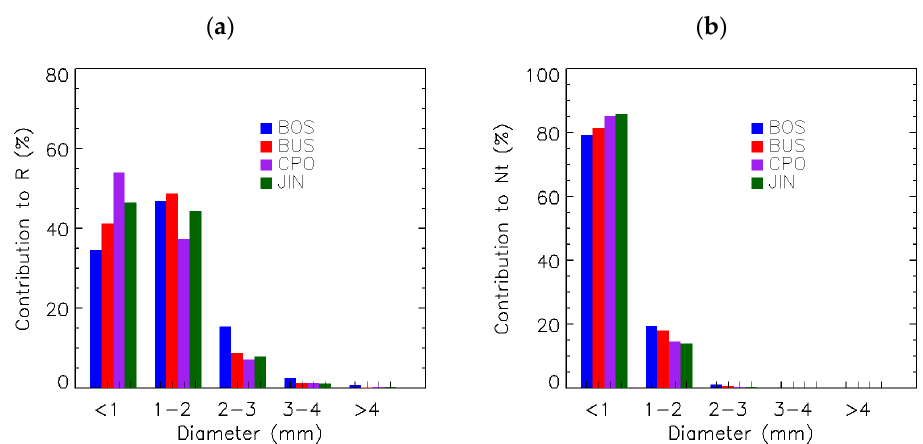
Figure 6. The contribution ratios of the raindrop diameter to ( a ) the rain rate and ( b ) the total number concentration. The blue represents BOS site, the red represents BUS site, the purple represents CPO site, and the green represents JIN site.